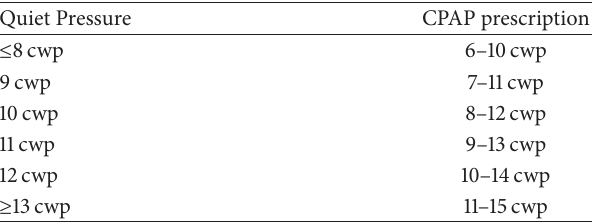
Table 5: CPAP prescription based on the Five-Minute CPAP Test Quiet Pressures ± 2cm of water pressure (cwp). Note: at our institution we selected 7–11cwp as the lowest